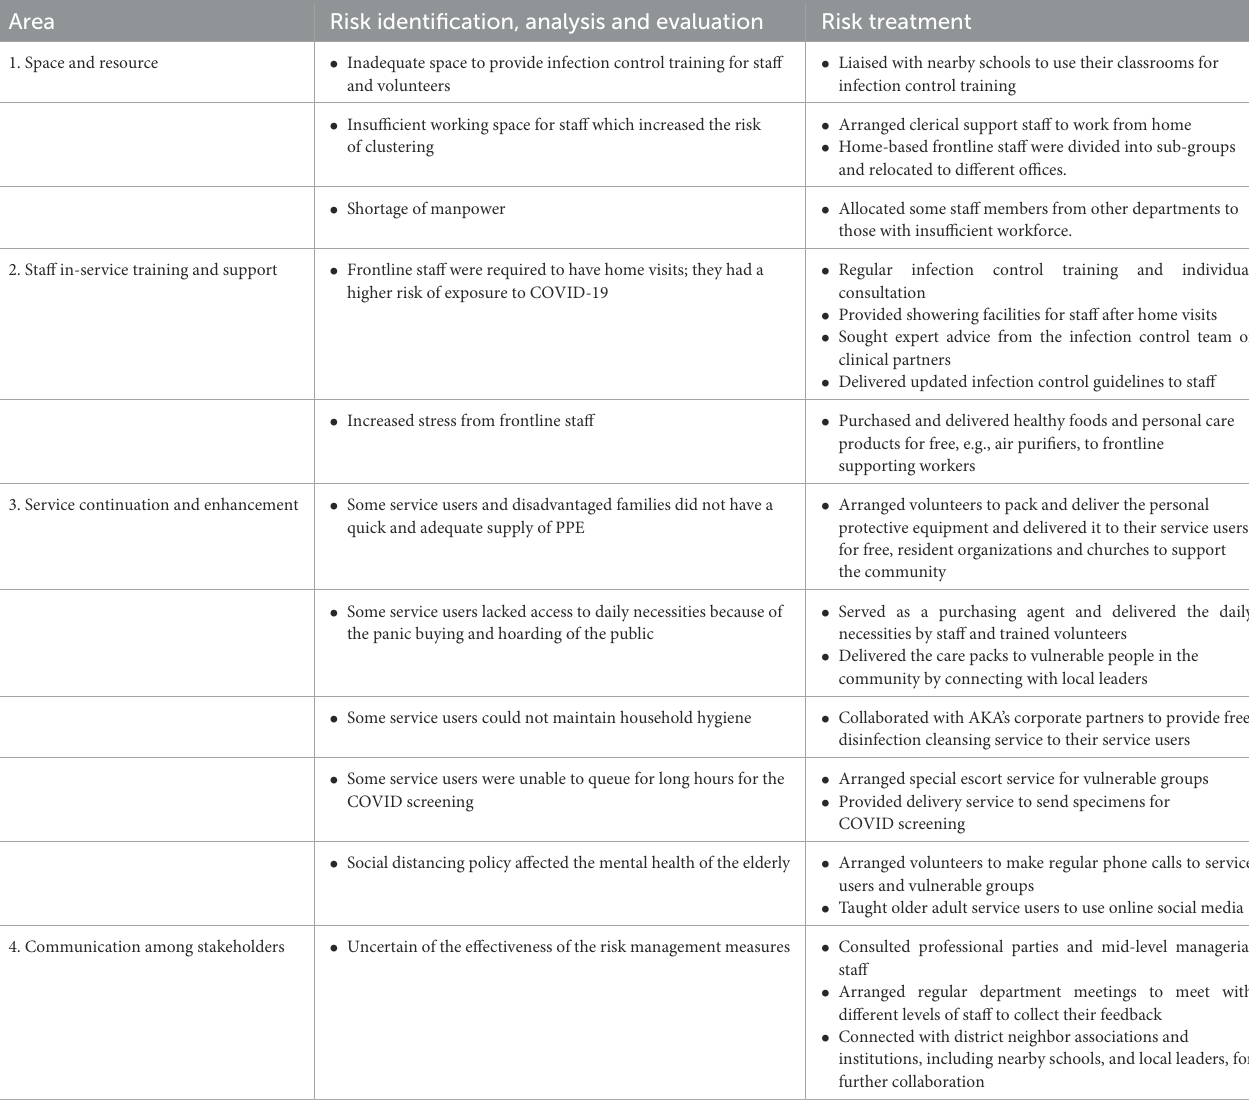
TABLE 1 The risk management process in four areas of home-based community care services in AKA amidst the COVID-19 pandemic. Area Risk identification, analysis and